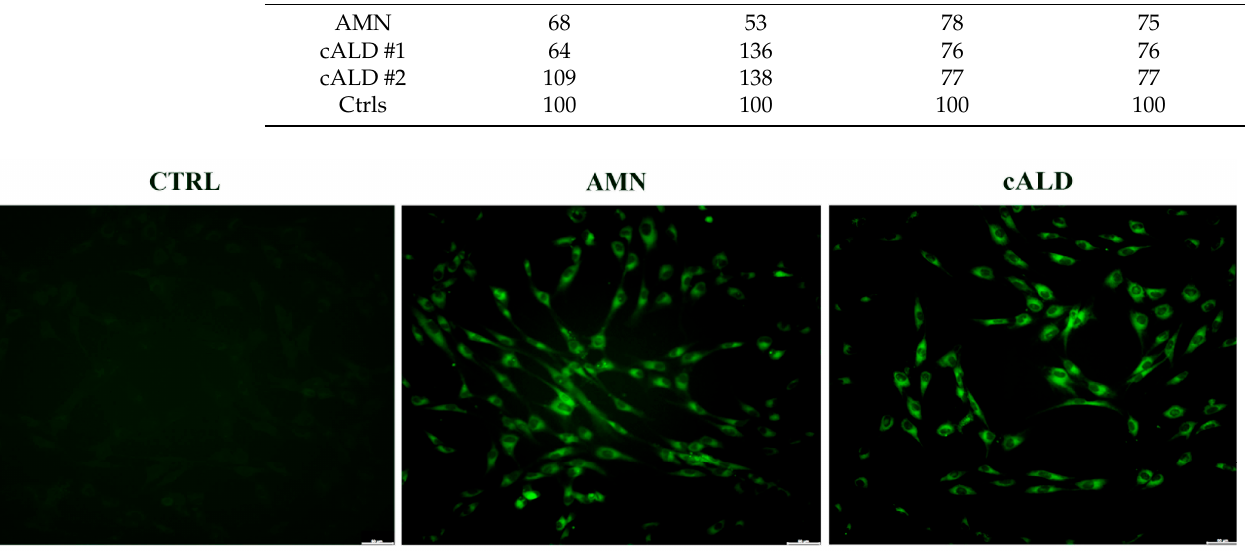
Figure 4. Antioxidant enzymes expression in fibroblasts of patient with X-ALD after 24 h treatment with NAC (100 uM). ( A , B ) Thiols and Glutathione (GSH) content. ( C , D ) Densitometric analysis of Gpx4, Gr, and Nqo1 protein levels. ( E ) Glutathione and proteins levels in AMN and cALD patients expressed as percentage with respect to untreated patients. Experiments were performed in tripli- cates and values expressed as mean ± SD. * p < 0.05, ** p < 0.01, compared to controls (by Student’s two-tailed t -test). # p < 0.05, #### p < 0.001, respect to untreated patient’s fibroblasts.